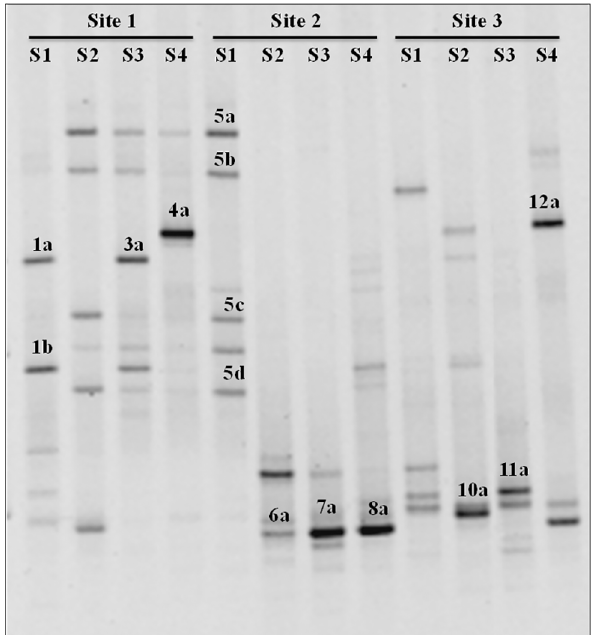
Fig 3. Denaturing Gradient Gel Electrophoresis (DGGE) profile of partial 18S rDNA amplification of Glomeraceae family. S1-S4 represents the samples obtained from each site. Band numbering refers to Glomeraceae ribotypes identified by sequencing are given in fig